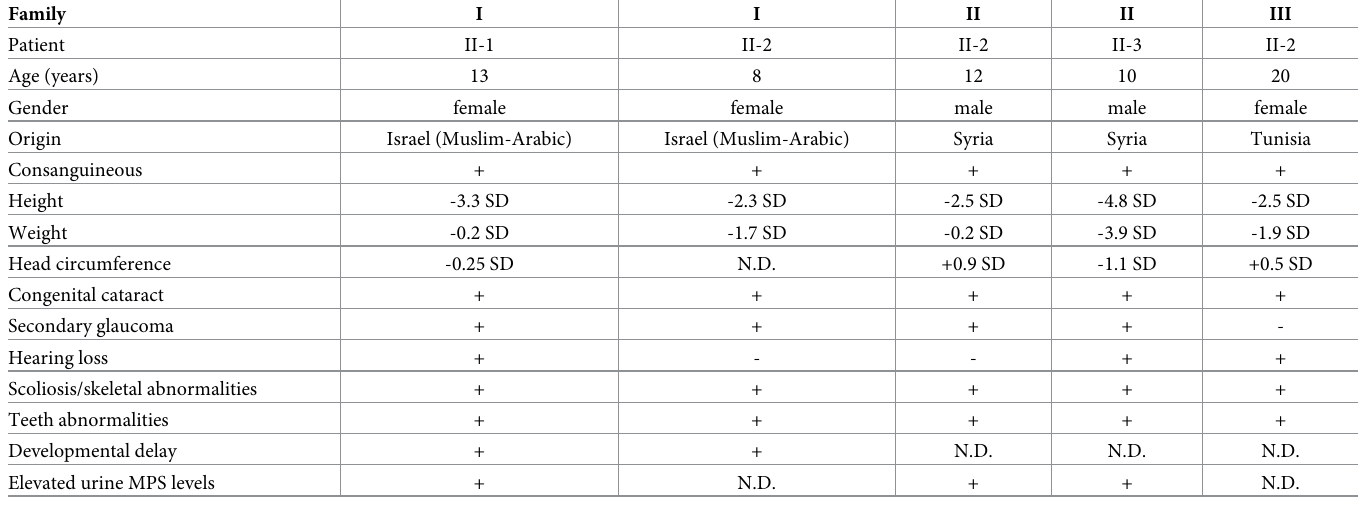
Table 1. Phenotypic characteristics of PIK3C2A deficient